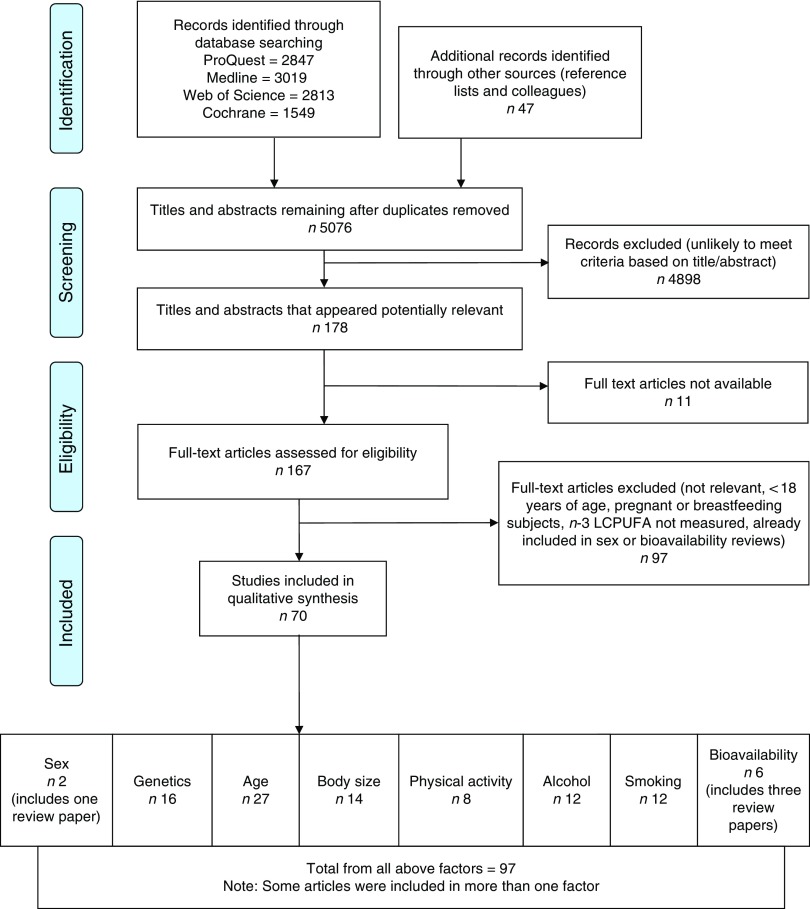
Flow diagram of systematic literature review search. The flow diagram outlines the identification, screening, eligibility and inclusion process of the systematic literature search. n-3 LCPUFA, n-3 long-chain PUFA.